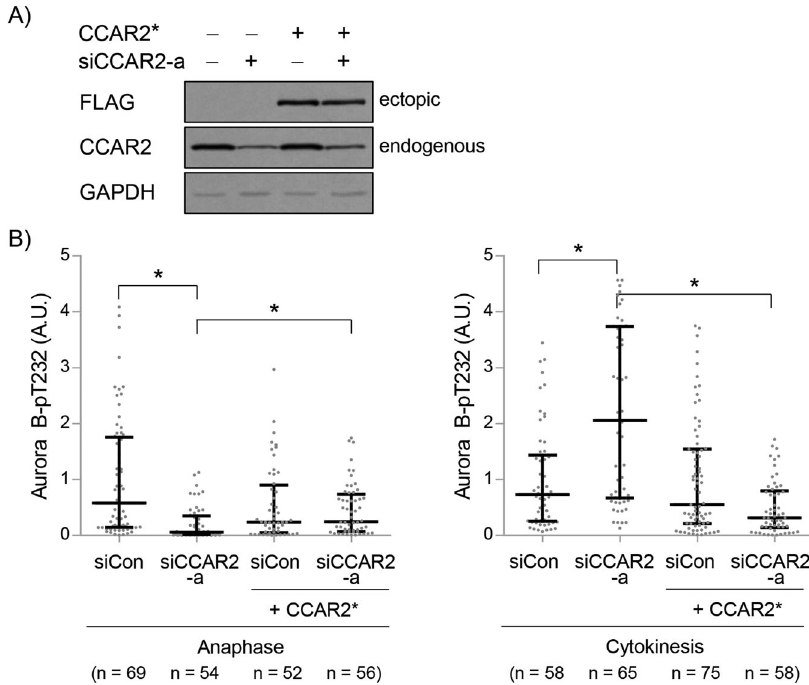
Fig. 8 CCAR2 is required for proper regulation of Aurora B during late mitosis. Cells were infected with siRNA-resistant FLAG-CCAR2(*) and then transfected with CCAR2 siRNA-a. A Expression of ectopic and endogenous CCAR2 was determined by western blotting. B Expression of CCAR2 was veri fi ed by immunostaining. The amount of Aurora B-pT232 at the spindle midzone and equatorial cortex during anaphase (left panel), and at midbody during cytokinesis (right panel) were determined by measuring fl uorescence intensity. The experiment was repeated independently ( N = 4). The number of anaphase or cytokinesis in all experiments ( n ) was presented in each graph. The fi rst and third bars are the 25th and 75th percentiles, respectively, and the second bar is the median. * p < 0.05, signi fi cantly different between each group (Kruskal – Wallis test); A.U., arbitrary